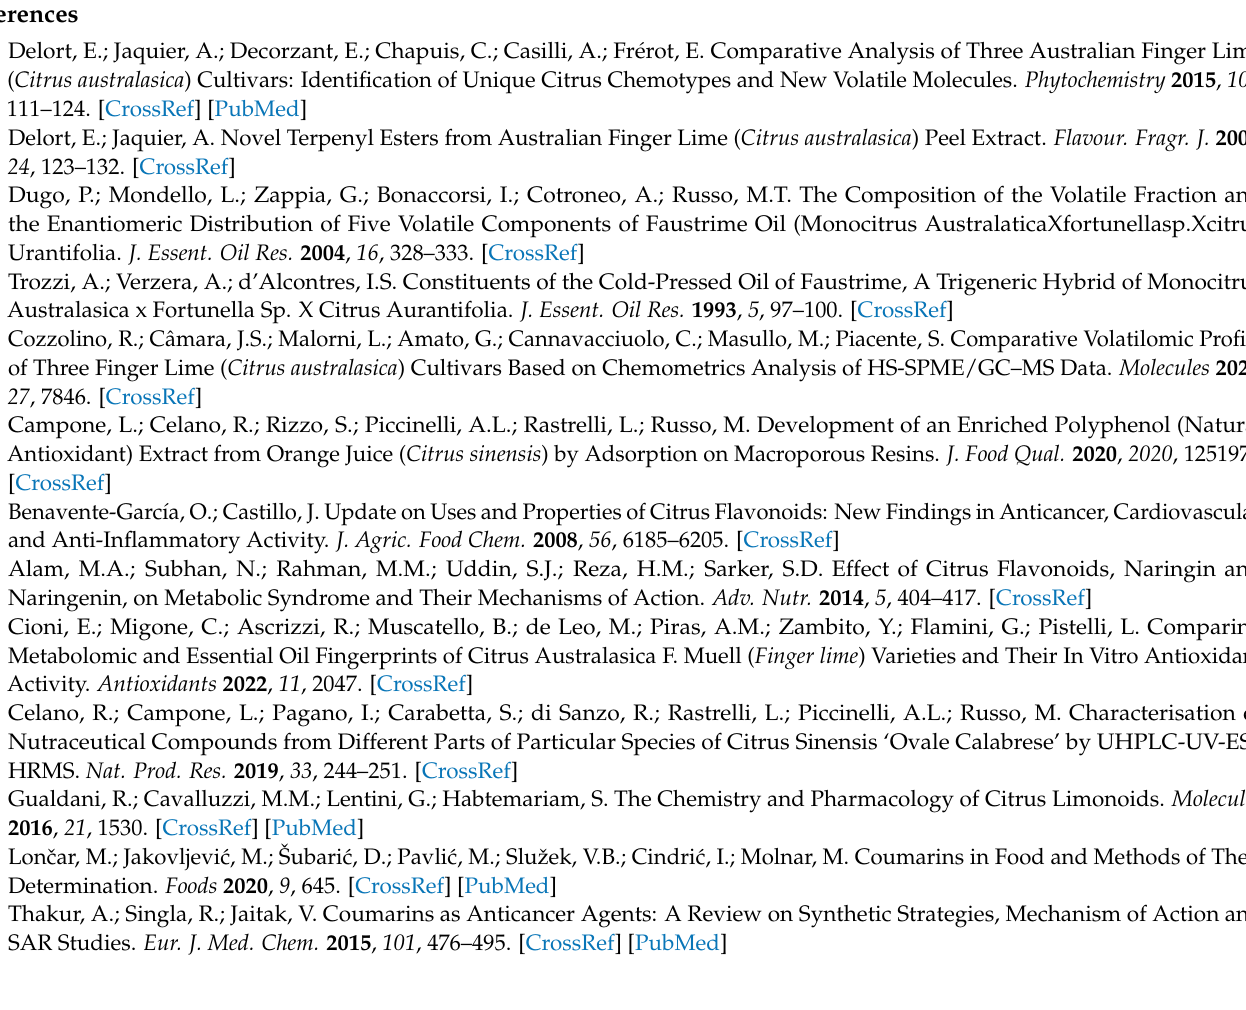
n-hexane extracts. Figure S2: UPLC-HRMS profiles of PPAS parts chloroform extracts. Figure S3: UPLC-HRMS profiles of PPAS parts methanol/water (50% v / v ) extracts. Figure S4: MS/HRMS spectra of compound 91. Figure S5: PCA Loading Plot. Figure S6: PCA Score Plot. Figure S7: PLS Loading Plot. Figure S8: PLS Score Plot. Table S1: Calibration curves for semi-quantitative